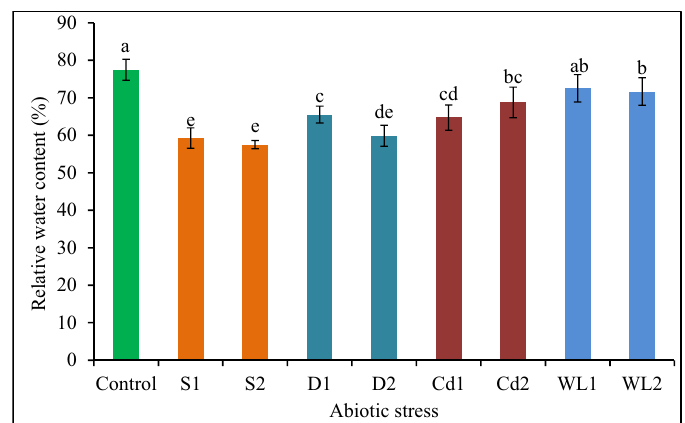
Figure 3: RWC of C. olitorius plants a ff ected by di ff erent abiotic stresses. S 1 , S 2 , D 1 , D 2 , Cd 1 , Cd 2 , WL 1 , and WL 2 represent 200 mM of NaCl, 400 mM of NaCl, 10 days of water de fi cit, 15 days of water de fi cit, 2 mM of CdCl 2 , 4 mM of CdCl 2 , 5 days of waterlogging, and 15 days of waterlogging, respectively. Mean value (± SD ) was calculated from three replicates for each treatment. Values in a column with di ff erent letters are signi fi cantly di ff erent at p ≤ 0.05 applying LSD